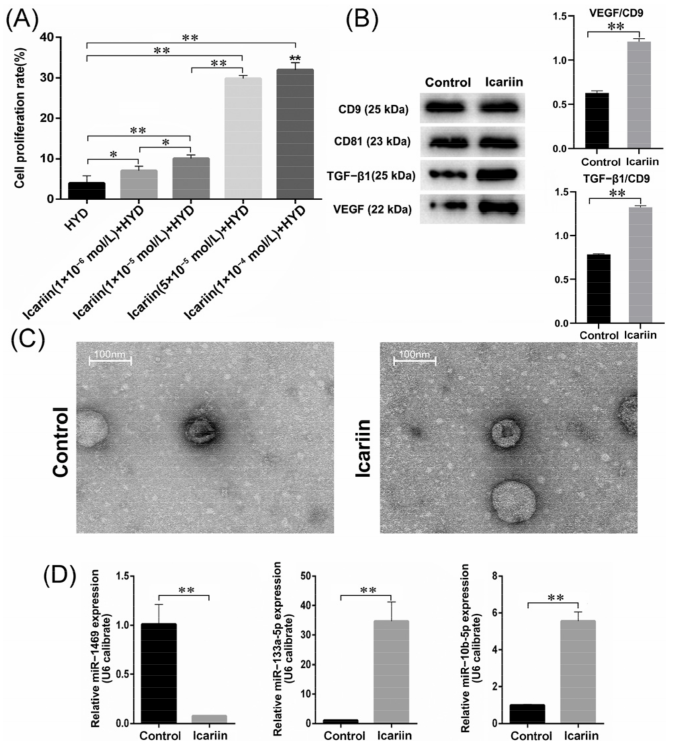
Figure 2. Icariin treatment and analysis of package in EVs. ( A ) Proliferation rate of BMECs increased with the concentration of icariin; effects of icariin in the 5 × 10 − 5 M and 1 × 10 − 4 M groups were most significant; ( B ) protein expression bands of VEGF, TGF- β 1, CD9, and CD81 in the EVs isolated from BMECs in the icariin group and the control group; ( C ) morphology of isolated EVs from BMECs in the icariin group and the control group, as determined by transmission electron microscopy; ( D ) the expression level of hsa-miR-1469, hsa-miR-133a-5p, and hsa-miR-10b-5p in EVs isolated from the icariin group and the control group measured by using qPCR. HYD indicated hydrocortisone (0.3 mg/mL). Data analysis was performed using t -test analysis and ANOVA, error bars indicate standard deviation, and ** means p < 0.01, * means p <